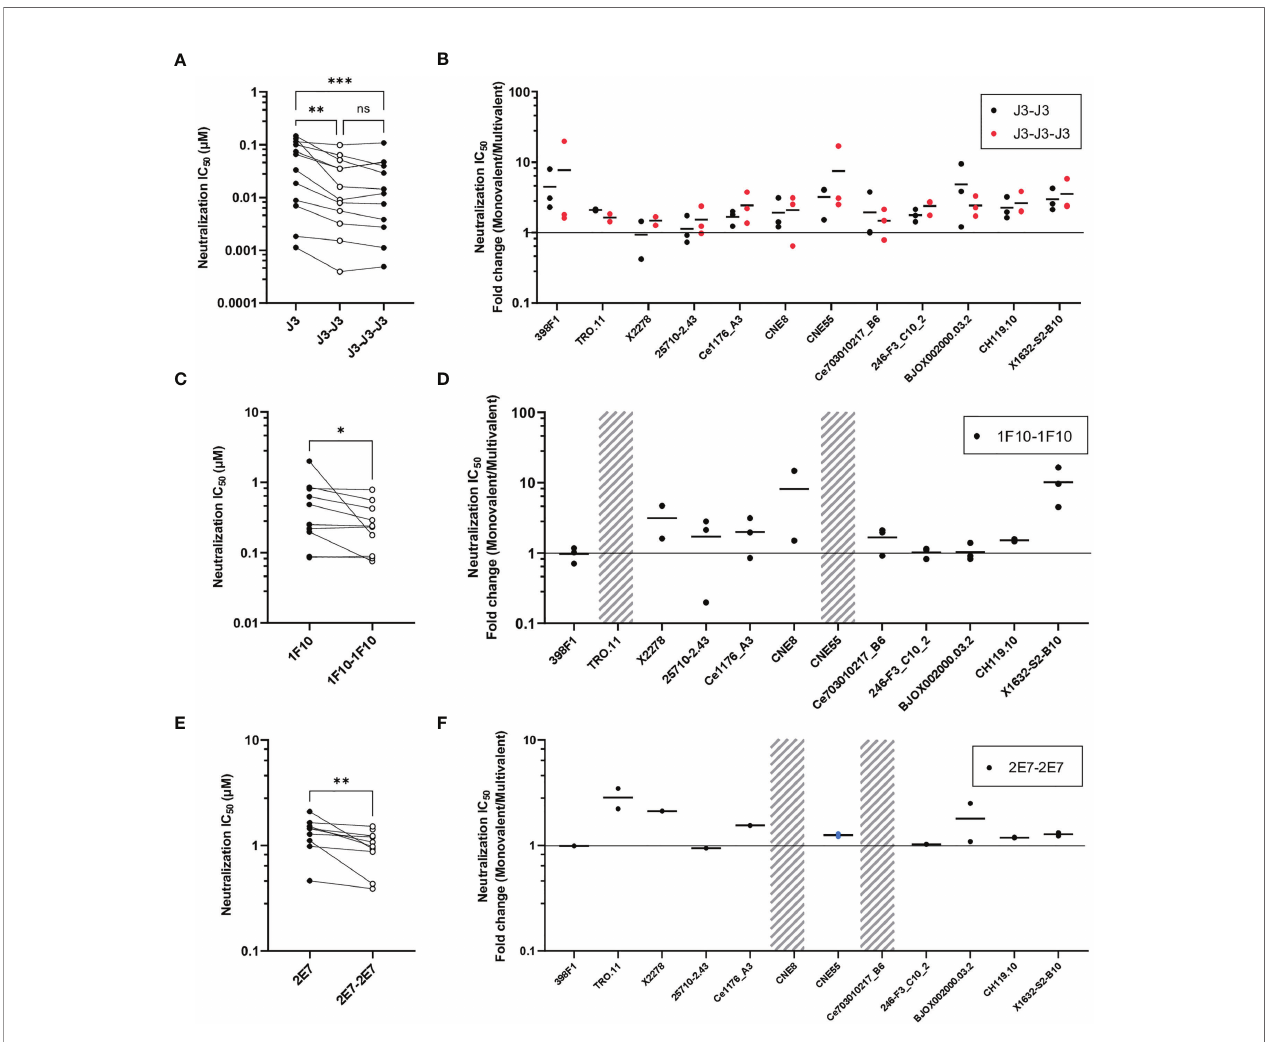
FIGURE 3 | Multivalent anti-HIV-1 nanobodies show enhanced neutralization capacity depending on target. (A) Neutralization IC 50 (µM) of J3 variants against 12 viruses from the global panel. (B) Neutralization capacity of bivalent (black dots indicate replicates) and trivalent J3 (red dots indicate replicates) as compared to monovalent J3 is depicted as fold change in IC 50. (C) Neutralization IC 50 (µM) of 1F10 variants against 12 viruses from the global panel. (D) Neutralization capacity of bivalent 1F10 as compared to monovalent 1F10 is depicted as fold change in IC 50 . (E) Neutralization IC 50 (µM) of 2E7 variants against 12 viruses from the global panel. (F) Neutralization capacity of bivalent 2E7 as compared to monovalent 2E7 is depicted as fold change in IC 50. Blue dots indicate neutralization by bivalent nanobody but not by monovalent nanobody. Absence of neutralization (IC 50 > 1 or 1.5 µM) is indicated with a grey shade. Friedman matched comparison (three groups) and Wilcoxon matched-pairs signed rank tests (two group) was used to compare IC 50 . Signi fi cance is indicated as *p < 0.05, **p < 0.005, ***p < 0.0005 and “ ns ” indicates not signi fi cant (p > 0.05). Data shown are the average of two or three independent